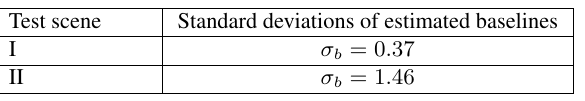
Table 2: Standard deviation of the estimated baselines for the small test scene I and the larger test scene II.